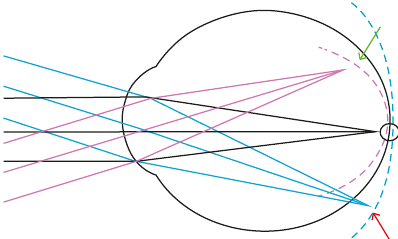
Figure 2: Peripheral hyperopic defocus (red arrow) might lead to axial elongation. A myopic defocus (green arrow) can be achieved with orthokeratology, contact lenses, laser refractive surgery, and spectacle lenses (defocus incorporated multiple segment lenses and Apollo progressive addition